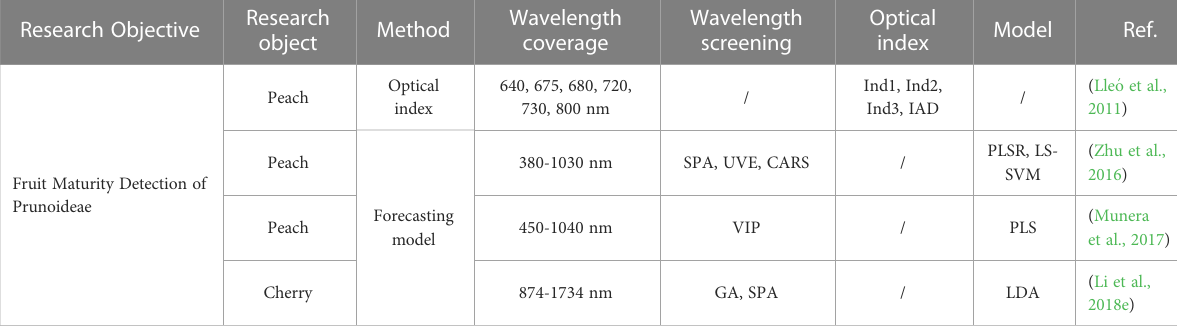
TABLE 4 Summary of research on maturity detection based on hyperspectral imaging.